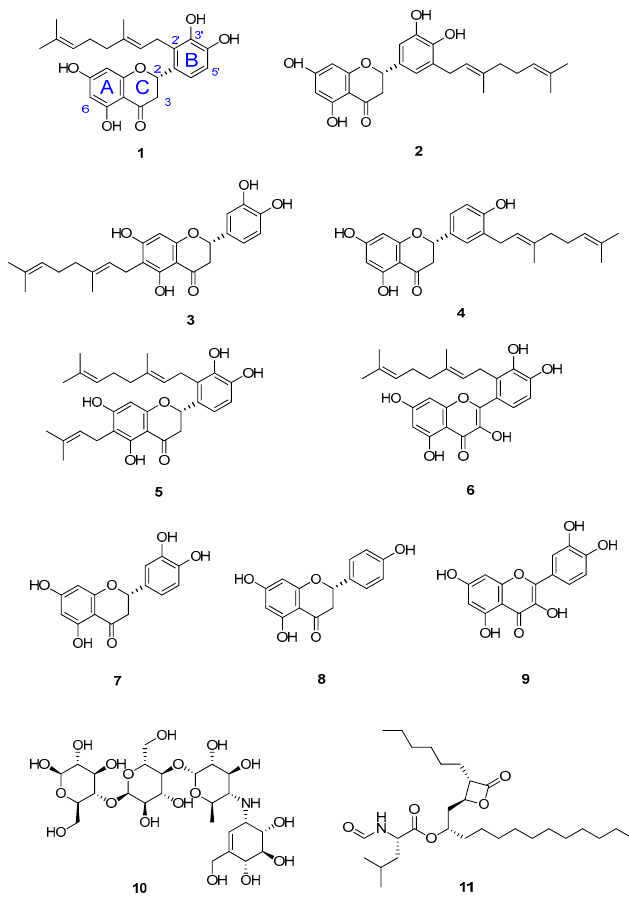
Figure 2. Chemical structures of compounds 1 – 6 isolated from the Australian propolis, their precur- sors eriodictyol ( 7 ); naringenin ( 8 ); and quercetin ( 9 ); antidiabetic drug, acarbose ( 10 ); and anti-obe- sity drug, orlistat ( 11 ).